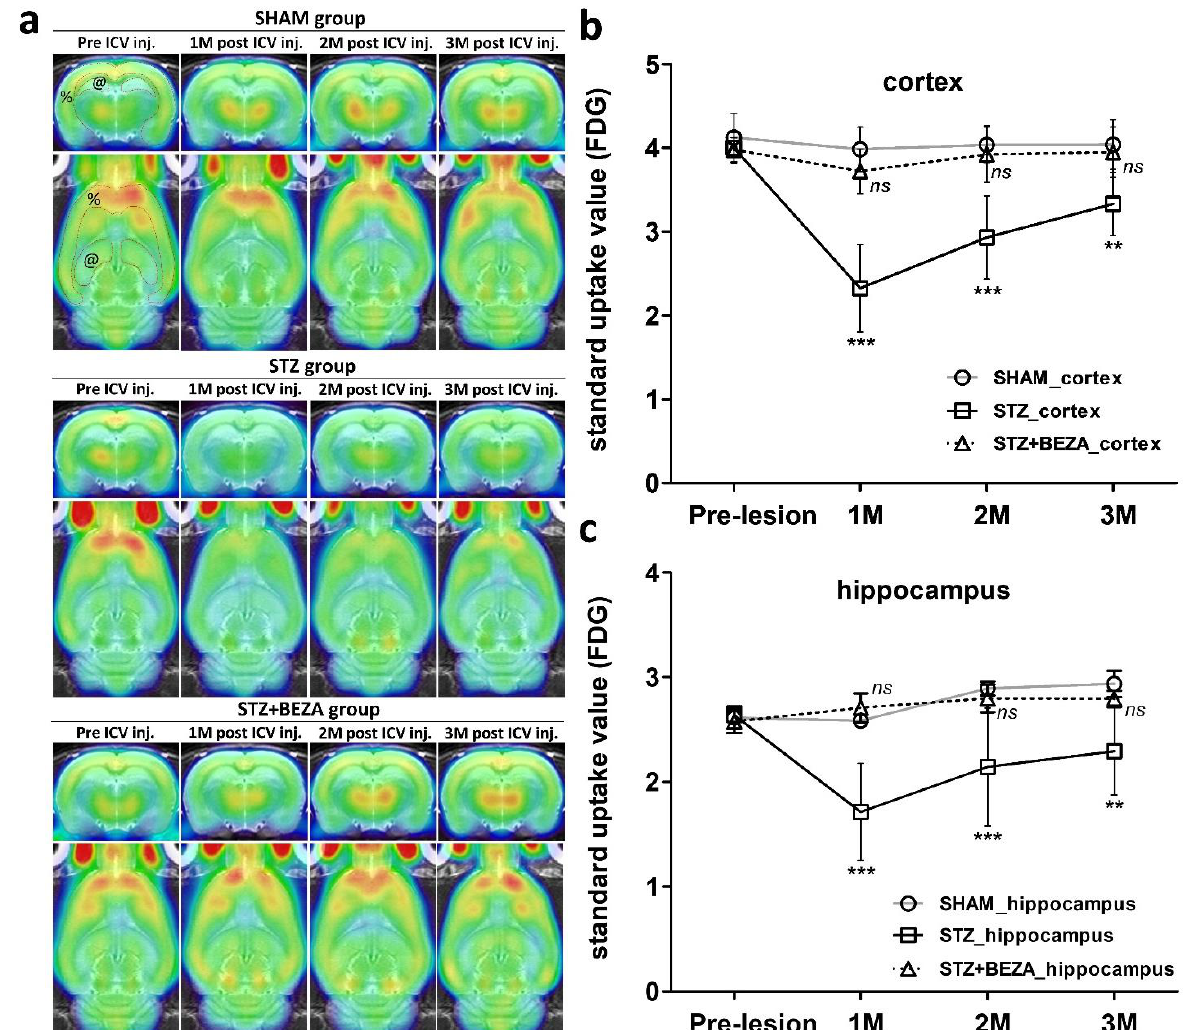
Figure 5. Bezafibrate prevented STZ-ICV-induced cerebral glucose hypometabolism. Animal PET with FDG was used for the in-vivo measurement of cerebral glucose utilization. After STZ-ICV administration, the cerebral FDG uptake was remarkably decreased in the STZ group but not in the SHAM and STZ+BEZA groups ( a ). Quantitative analysis of FDG uptake revealed that STZ-ICV administration caused a significant reduction in SUVs in the cortex ( b ) and hippocampus ( c ). The decline was most remarkable in the first month with a partial but incomplete recovery. Bezafibrate treatment successfully prevented STZ-ICV-induced cerebral glucose hypometabolism, as there was no significant difference in SUVs between the STZ+BEZA and SHAM groups until the third month. Red dotted lines indicate representative delineation of cortex [%] and hippocampus [@]. Data are presented as mean ± SD; **, p < 0.01, ***, p < 0.001, ns , not significant, vs. SHAM group at the same time point; n = 6, per group.